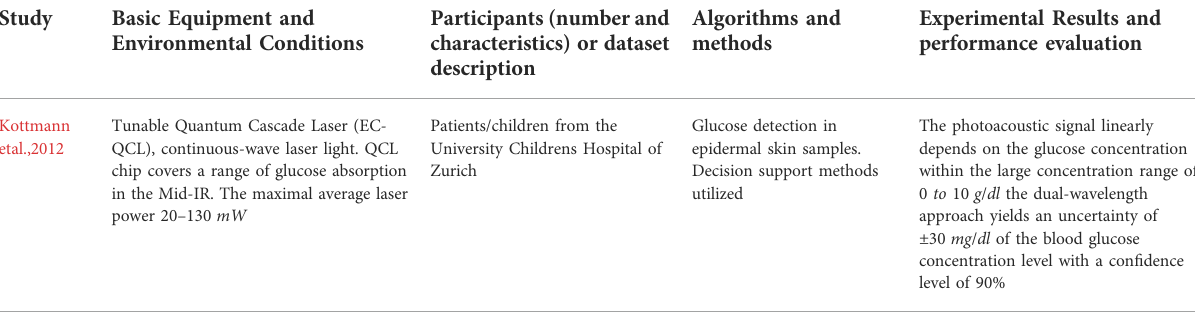
TABLE 5 Summary of the literature for diabetic foot monitoring using mid-infrared